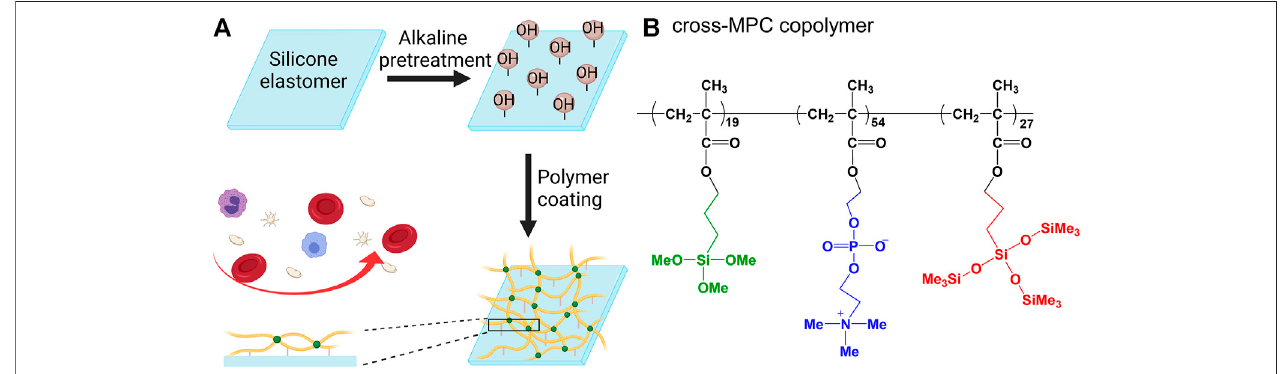
FIGURE 1 | Schematic coating procedure for the cross-MPC copolymer fi lm on silicone elastomer (SE) surface (A) ; Chemical structure of the cross-MPC- copolymer (B) .